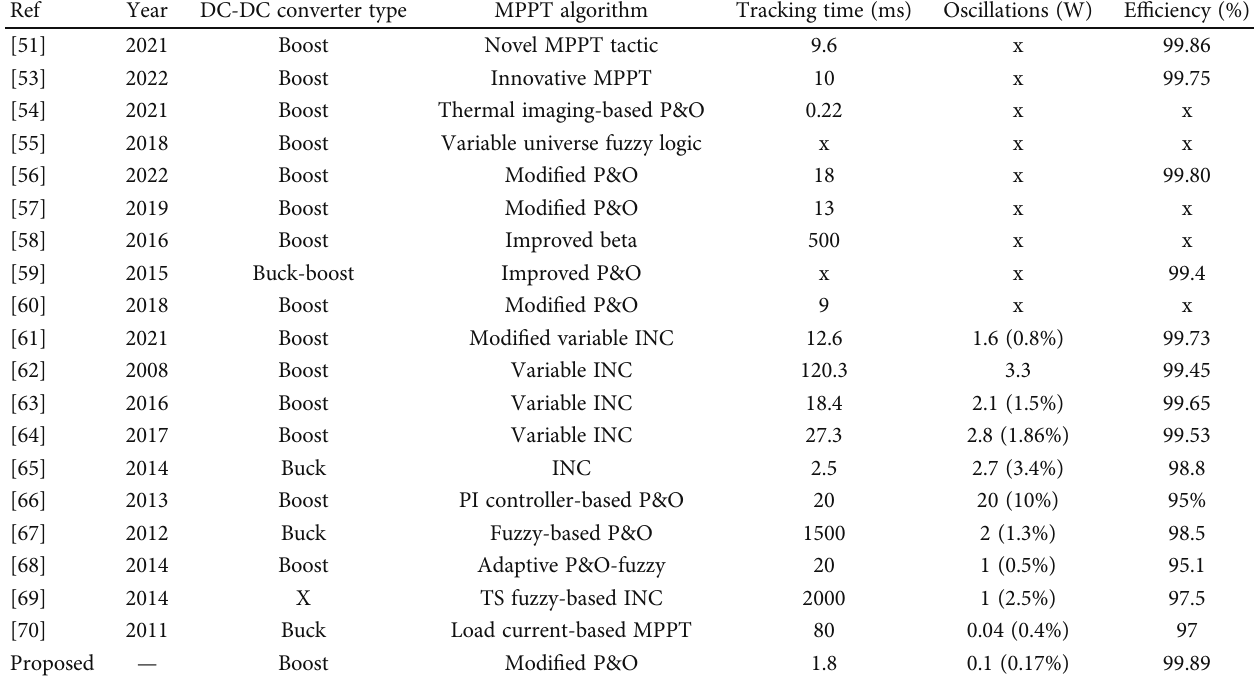
Table 7: Comparison of the enhanced MPPT algorithm with other MPPT methods in literature at